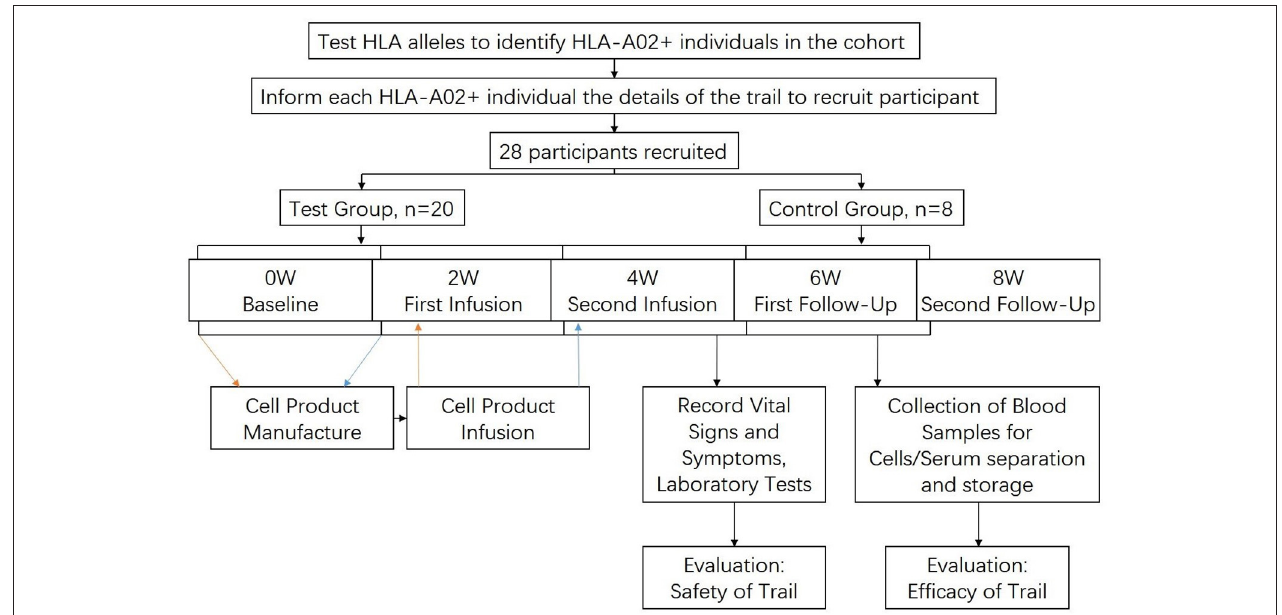
FIGURE 1 | Flow chart showing the procedure of the trial.